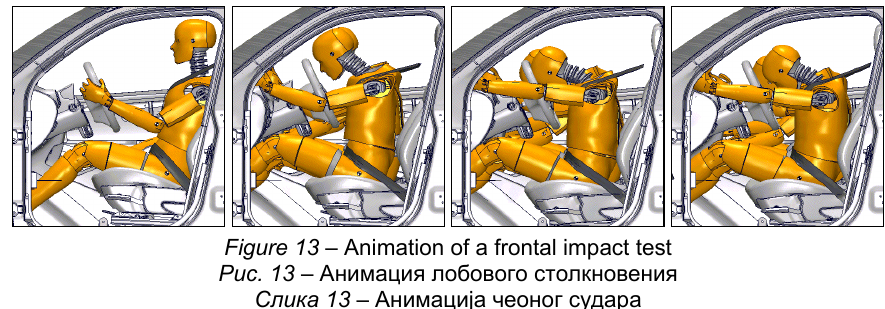
Figure 13 – Animation of a frontal impact test Рис . 13 – Анимация лобового столкновения Слика 13 – Анимација чеоног